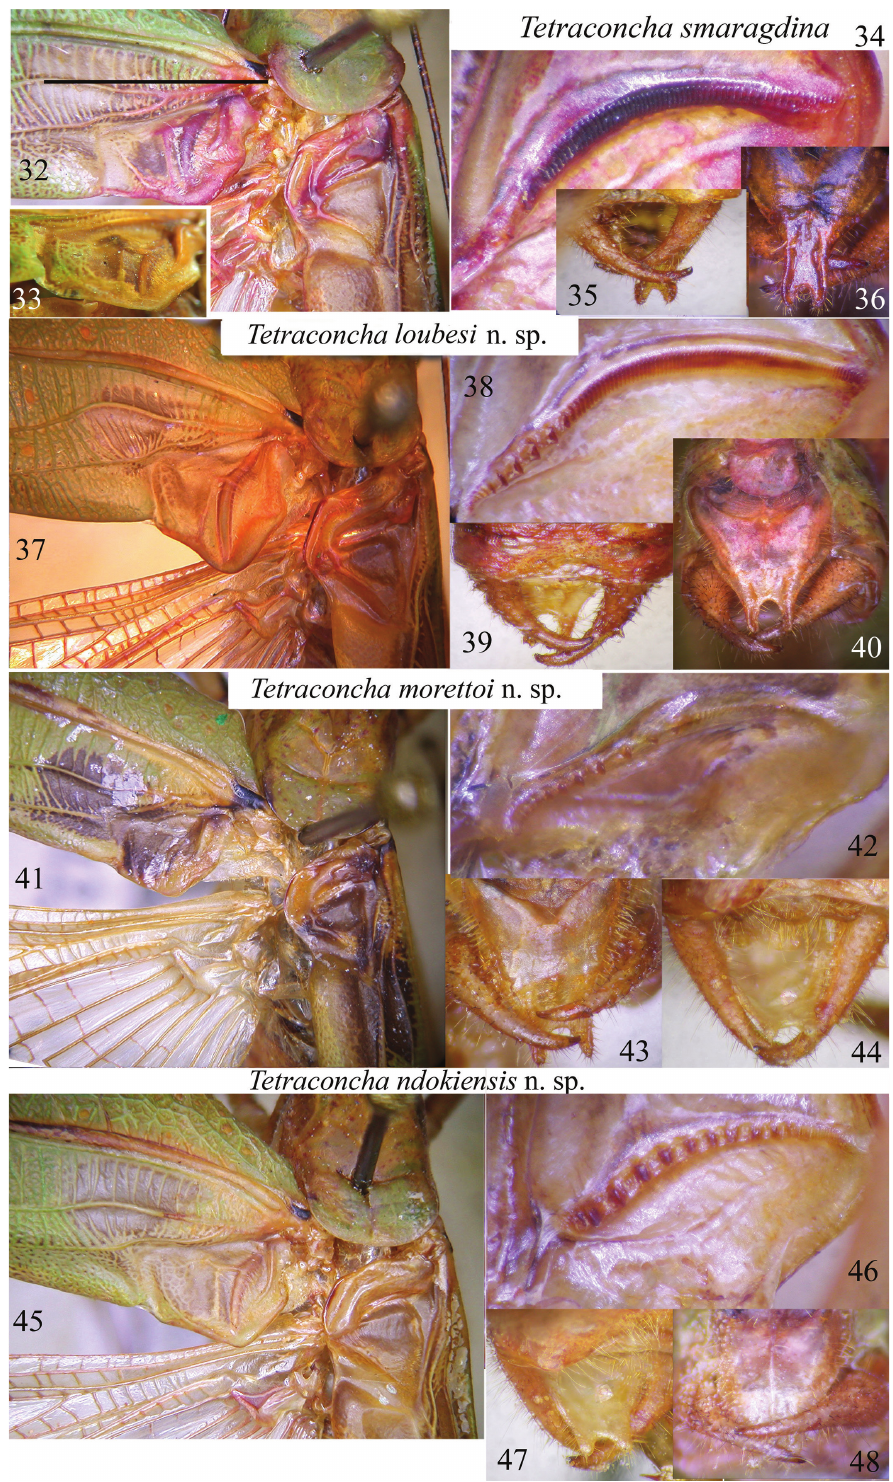
Figs 32–48. Tetraconcha smaragdina male (Central African Republic, N’Doki): 32. Stridulatory area (the arrow shows the distance be- tween the base of left tegmen and the maximum width of cubital areas); 33. Stridulatory area of the holotype (Cameroon); 34. Stridu- latory file below the left tegmen; 35. Cerci in dorsal view; 36. Subgenital plate in ventral view of the holotype. Tetraconcha loubesi sp. n. holotype male (Central African Republic, N’Doki): 37. Stridulatory area; 38. Stridulatory file below the left tegmen; 39. Cerci in dorsal view; 40. Subgenital plate in ventral view). Tetraconcha morettoi sp. n. holotype male (Central African Republic, N’Doki): 41. Stridula- tory area; 42. Stridulatory file below the left tegmen; 43. Subgenital plate in ventral view; 44. Cerci in dorsal view. Tetraconcha ndokiensis sp. n. holotype male (Central African Republic, N’Doki): 45. Stridulatory area; 46. Stridulatory file below the left tegmen; 47. Subgeni- tal plate and cerci in dorsal view; 48. Subgenital plate and cerci in ventral